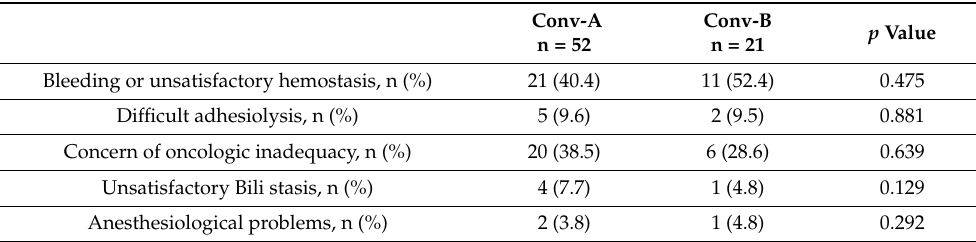
Table 2. Conversions and reasons in MILRs for HCC in Child A and in advanced cirrhosis (Child B and Child A/B with portal hypertension) patients.